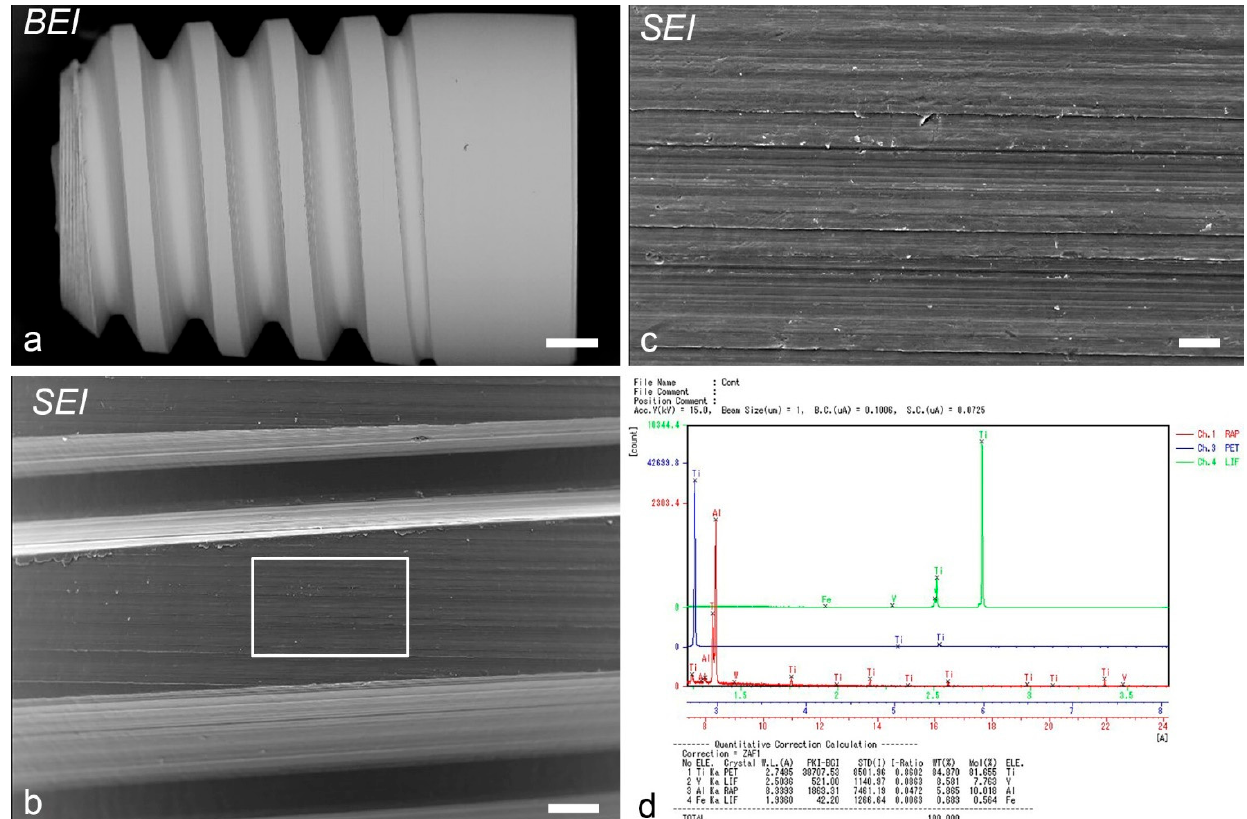
Figure 8. The surface morphology of a non-blasted implant ( a – c ) and the percentage weights of each element on the implant surface ( d ) as determined by EPMA. ( a ) A backscattered electron image of the implant. ( b , c ) A secondary electron image of the implant. ( c ) Higher magnification of the boxed area in ( b ). ( d ) Quantitative data of minerals on the implant surface. Scale bars = ( a ) 200 µ m, ( b ) 50 µ m, and ( c ) 10 µ